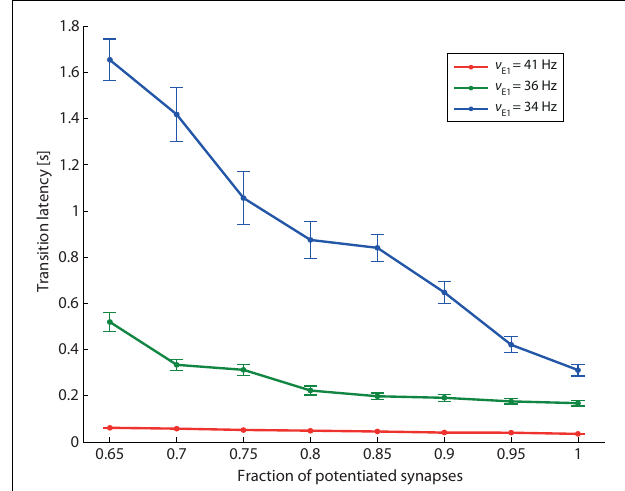
FIGURE 9 |Transition latency and recurrent connectivity. Latency of transition from low spontaneous state of E att activity to its high meta-stable state induced by stimulation (same protocol as Figure 8 ), as a function of the recurrent connectivity of population E att (fraction of potentiated synapses) and of the strength of external stimulation ( ν E1 increasing from a baseline of 24Hz to an elevated level of either 34, 36, or 41Hz (blue, green, and red curves, respectively).